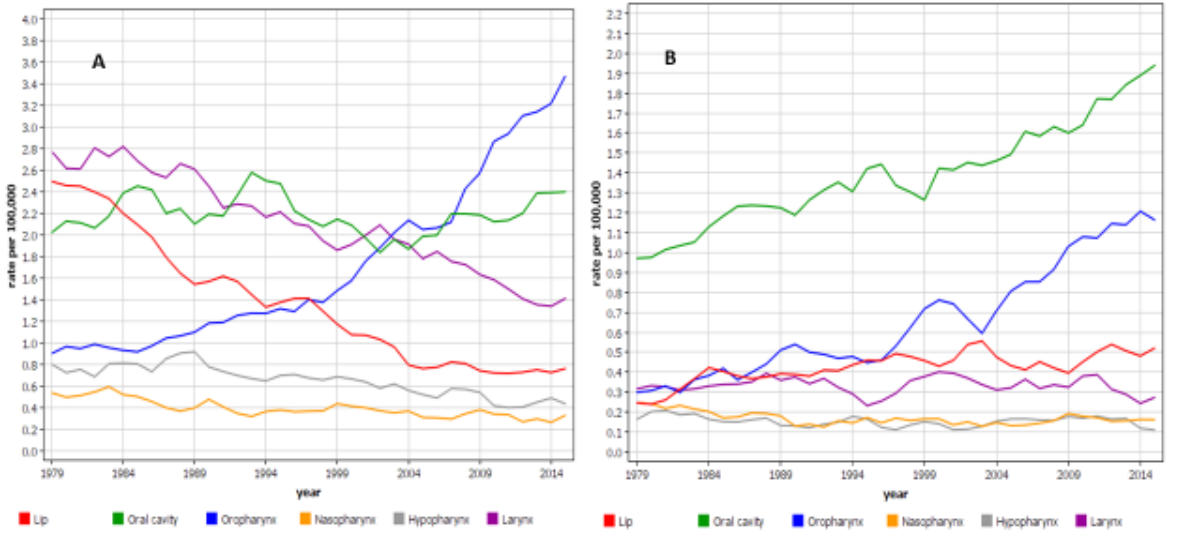
Figure 1. Age-standardized incidence per 100,000 in head and neck cancers in Sweden from 1978 to 2016 based on the Nordcan database for ( A ) men and ( B ) women. Note the difference in the scale for the y-axis. The curves are based on male/female patient numbers, which were 4636/1861 for lip, 6366/5201 for oral cavity, 4858/1925 for oropharynx, 964/460 for nasopharynx, 1936/529 for hypopharynx, and 6420/1047 for larynx. The data points were smoothened over 3 years.